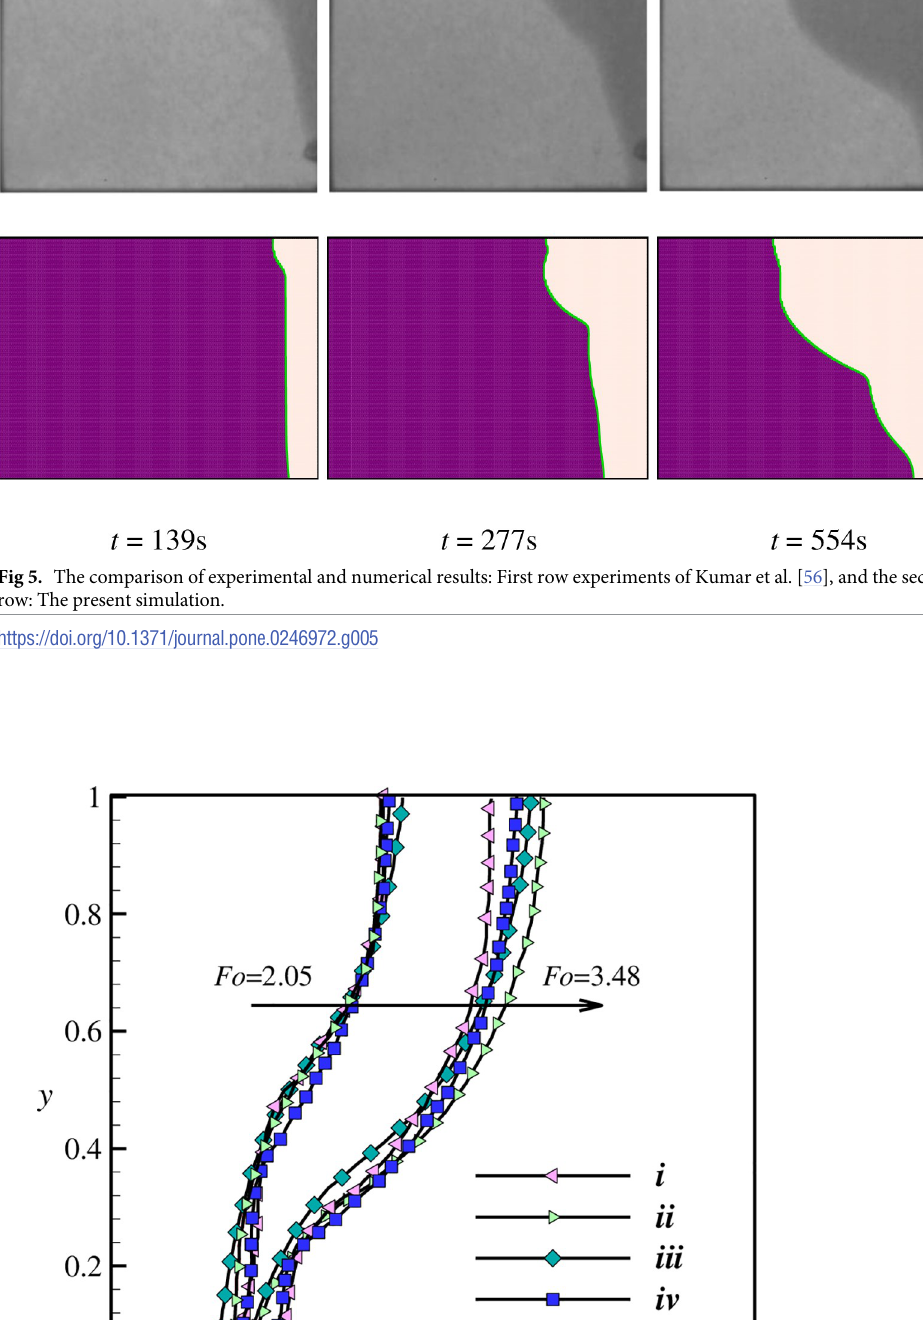
PLOS ONE | https://doi.org/10.1371/journal.pone.0246972 March 24,